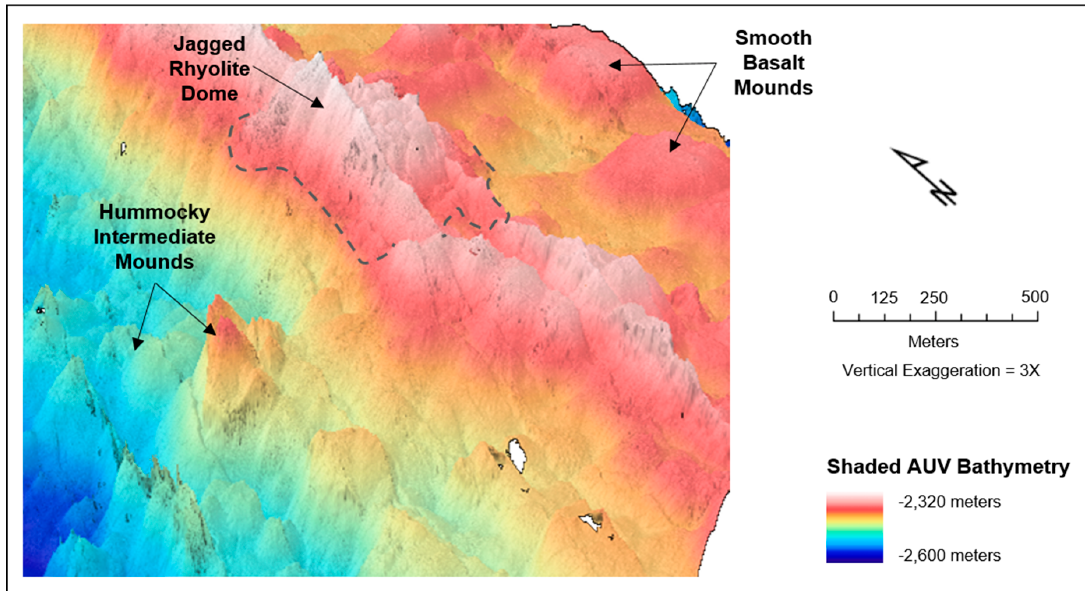
Figure 13. Intermediate-composition lava flows form hummocky mounds west of the north ridge at the Alarcon Rise. These mounds are similar in diameter to basaltic pillow mounds (100–200 m) but form rougher textures. We attribute the hummocks to the formation of large megapillows (>1 m diameter). Vertical exaggeration = 3X.